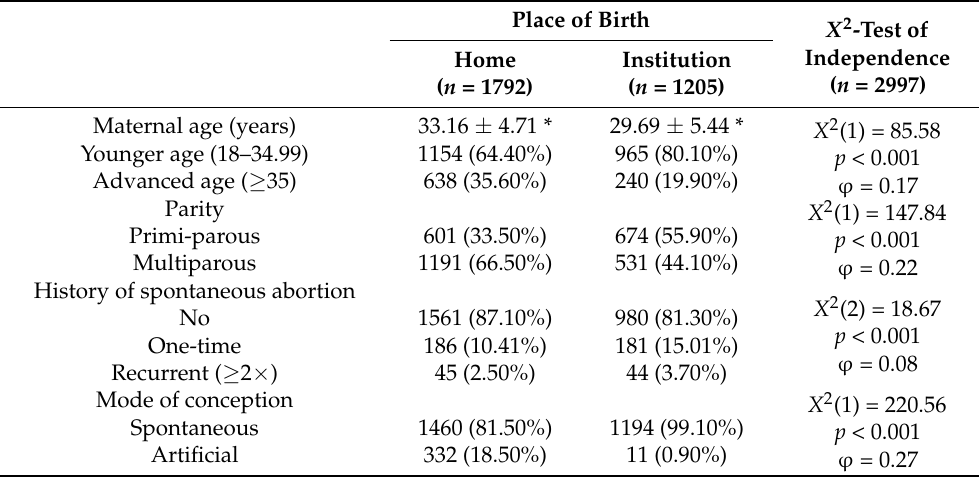
Table 1. Baseline characteristics of women who experienced home births and institutional births in Hungary from 2012–2020.